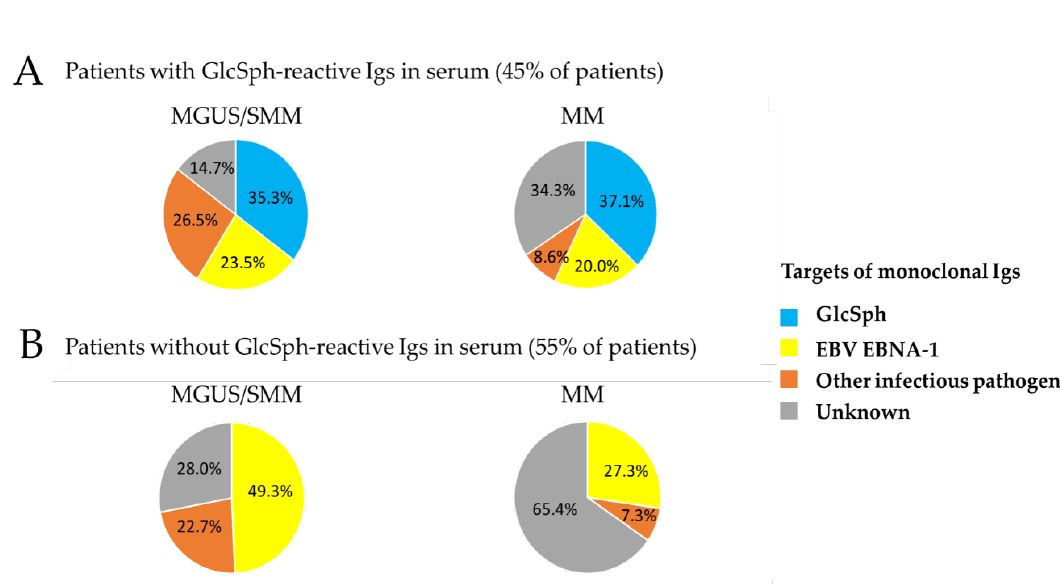
Figure 3. Identified targets of monoclonal Igs in MGUS / SMM and MM, according to the presence or absence of GlcSph-reactive Igs. Representation of the percentage (%) of patients with a monoclonal Ig that targets GlcSph, EBV EBNA-1, or another MIAA pathogen. “Unknown”: patients for whom the target of the monoclonal Ig has not been identified (unknown target). ( A ) Targets of monoclonal Igs from patients with GlcSph-reactive Igs (clonal or non-clonal). ( B ) Targets of monoclonal Igs from patients who do not have GlcSph-reactive Igs.